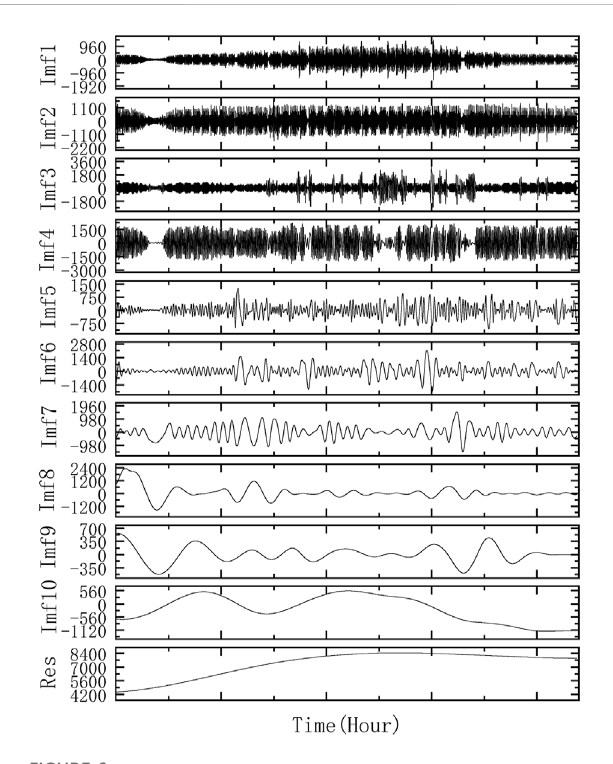
FIGURE 6 Results of the decomposition of Case 1 CEEMDAN. FIGURE 8